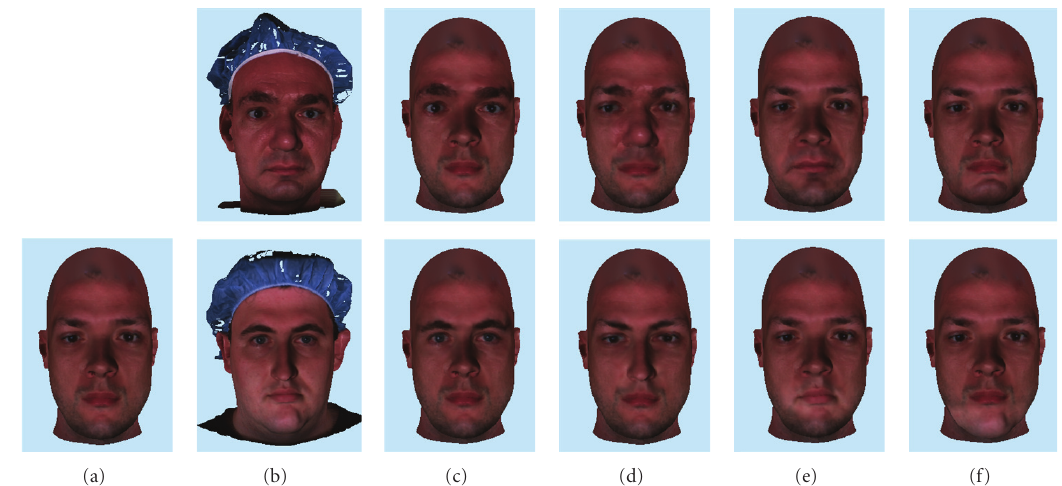
Figure 15: Transfer of facial features. We start with a source model (a) and synthesize facial features of the eyes (c), nose (d), mouth (e) and chin (f) on it by coercing the shape parameters to match those of two example faces (b). is slightly larger than that of females, whereas the